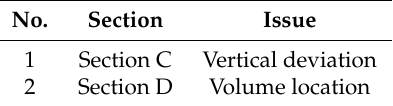
Table 2. Quality monitoring